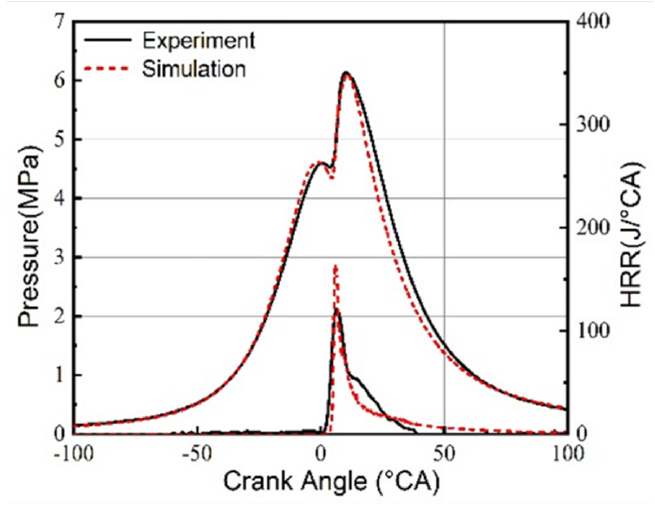
Figure 2. Comparison between simulation and experiment results of combustion pressure and heat release rate in cylinder.